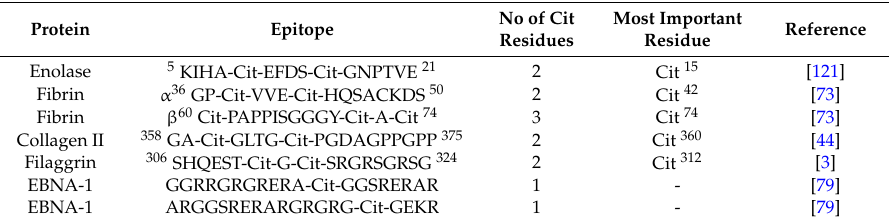
Table 3. Reactive anti-citrullinated protein antibody